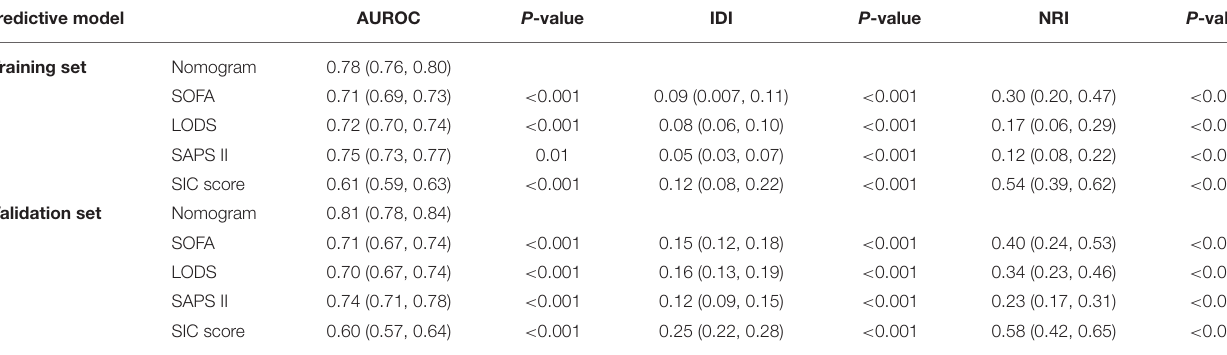
TABLE 4 | Comparison of models in predicting the 28-day mortality of patients with SIC. Predictive model